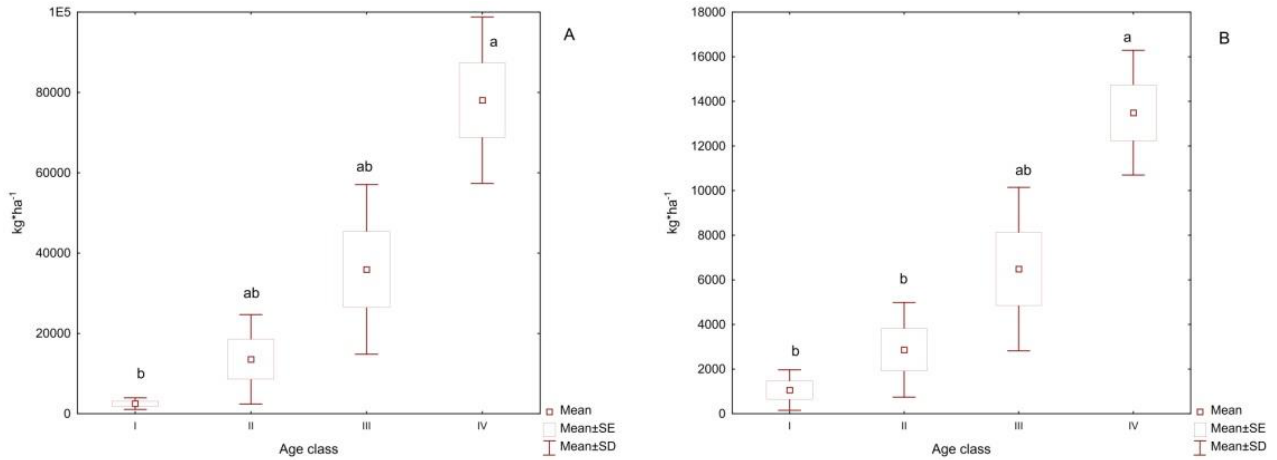
Figure 1. Average of aboveground ( A ) and belowground ( B ) biomass in the studied chronosequence (a,b mean significant differences of the soils properties between chronosequences).